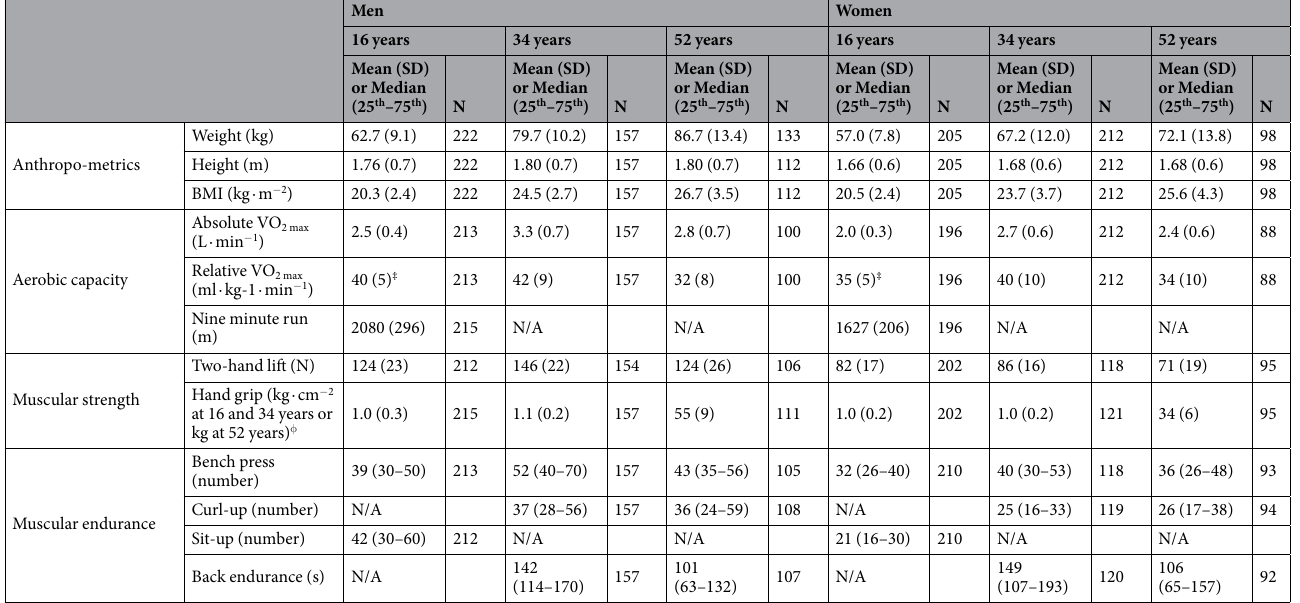
Table 1. Descriptive statistics for the anthropometrics and the physical capacity test at 16, 34 and 52 years of Different equipment were used so the absolute numbers are not comparable between the ages or between the genders. ‡ The value at 16 years of age is estimated from the nine minute run